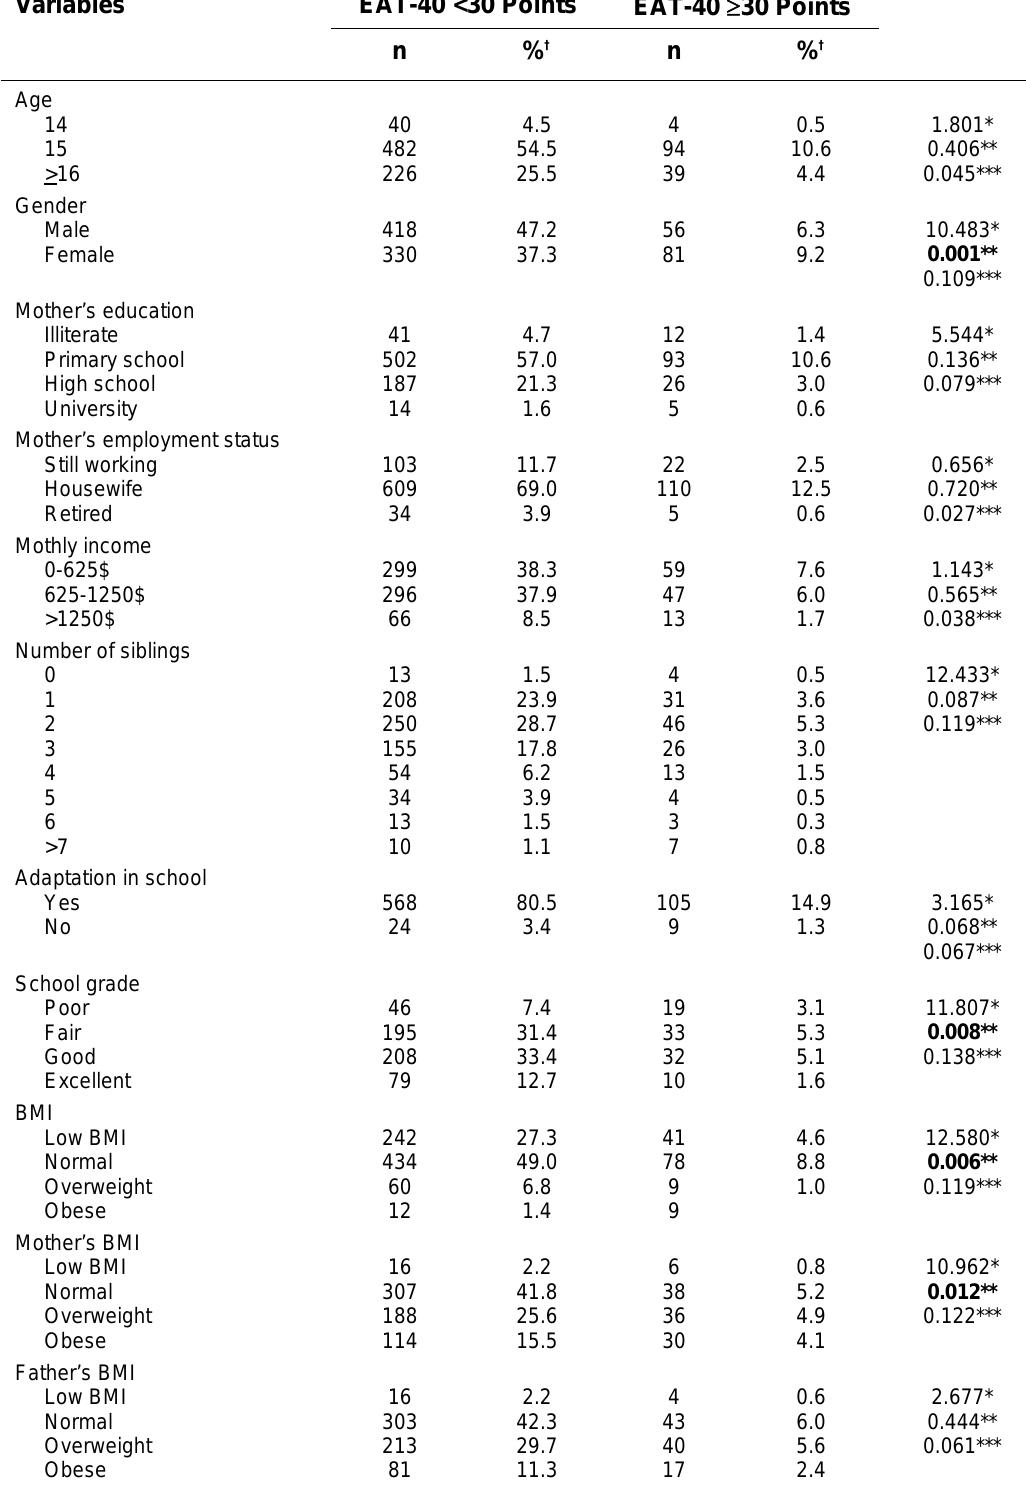
Distribution of Study Group According to EAT-40